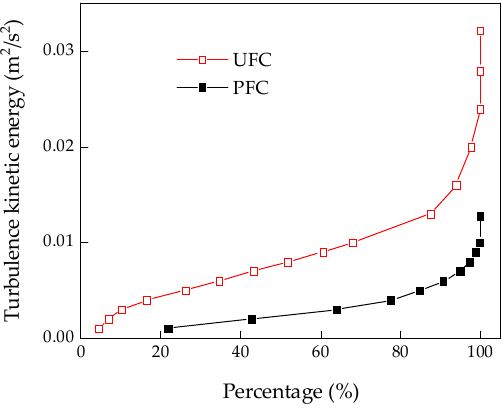
Figure 8. Turbulence kinetic energy of cumulative volume as the function of UFC and PFC.